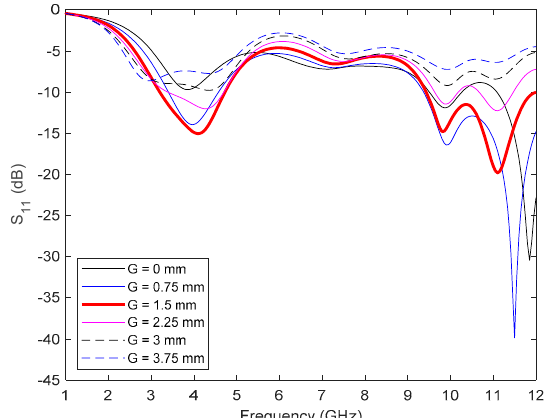
Figure 2. Reflection coefficient for the rectangular monopole antenna for different values of G . Table 1. Dimensions of the Designed Antenna.